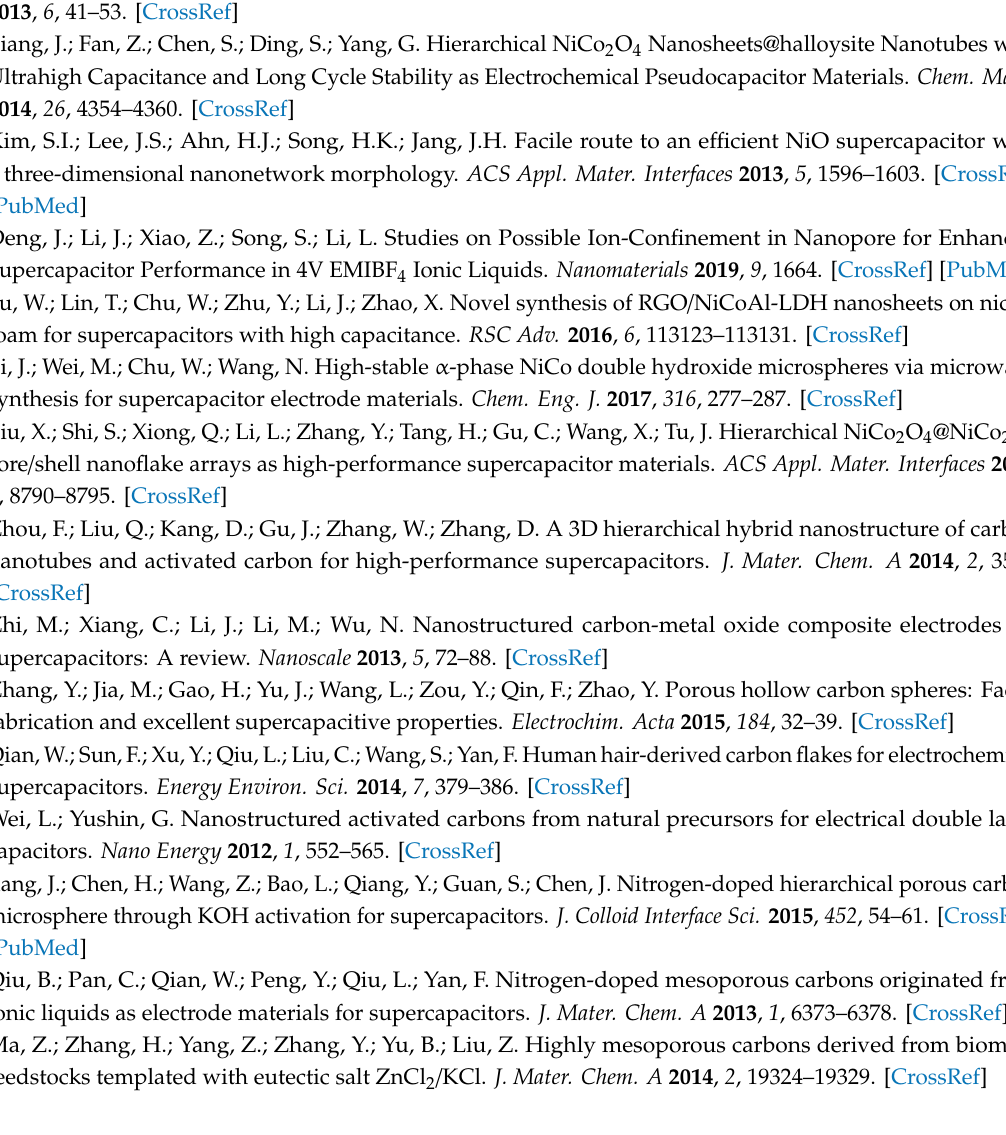
Figure S1: PSD of samples, Figure S2: N 2 adsorption-desorption isotherm of KAC-800-900, Figure S3: PSD of KAC-800-900, Figure S4: XRD pattern of KAC-800-900, Figure S5: DTG curves of KAC-800 and KAC-800-900, Table S1: The proximate analysis and element analysis data of anthracite, Table S2: Textural properties of KAC-800-900 (Calculated total surface area S BET , total pore volume V T , average pore diameter d M ), Table S3: Textural properties and chemical composition of KAC-800 and KAC-800-900 (atomic percent of elements obtained from XPS